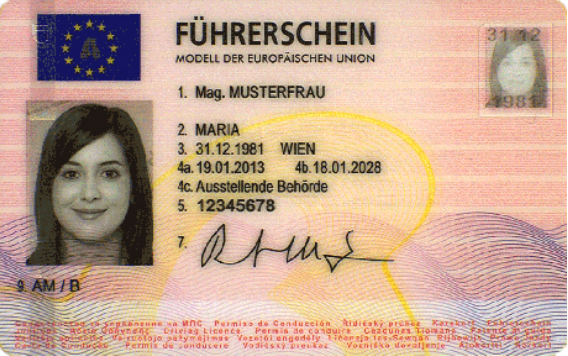
Figure 9. The template of the new Austrian driving license